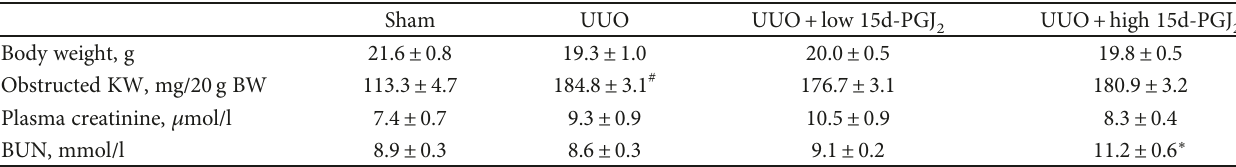
Biochemical values. Mice were subjected to UUO for 3 days (UUO) and treated with 15d-PGJ2 at a low dose (0.5 mg/kg/day) and a high dose (1mg/kg/day). At the time of sacri fi ce, a blood sample was taken from the left ventricle. Body weight and obstructed kidney weight were measured. Plasma creatinine and BUN were measured using Roche Cobas 6000 analyzer (Roche Diagnostics, Hvidovre, Denmark). Values are means ± SEM, n = 6 . # P < 0 05 versus that in sham. ∗ P < 0 05 versus that in UUO. 15d-PGJ2: 15-deoxy- Δ 12,14 -prostaglandin J 2 ; BW: body weight; KW: kidney weight; BUN: blood urea